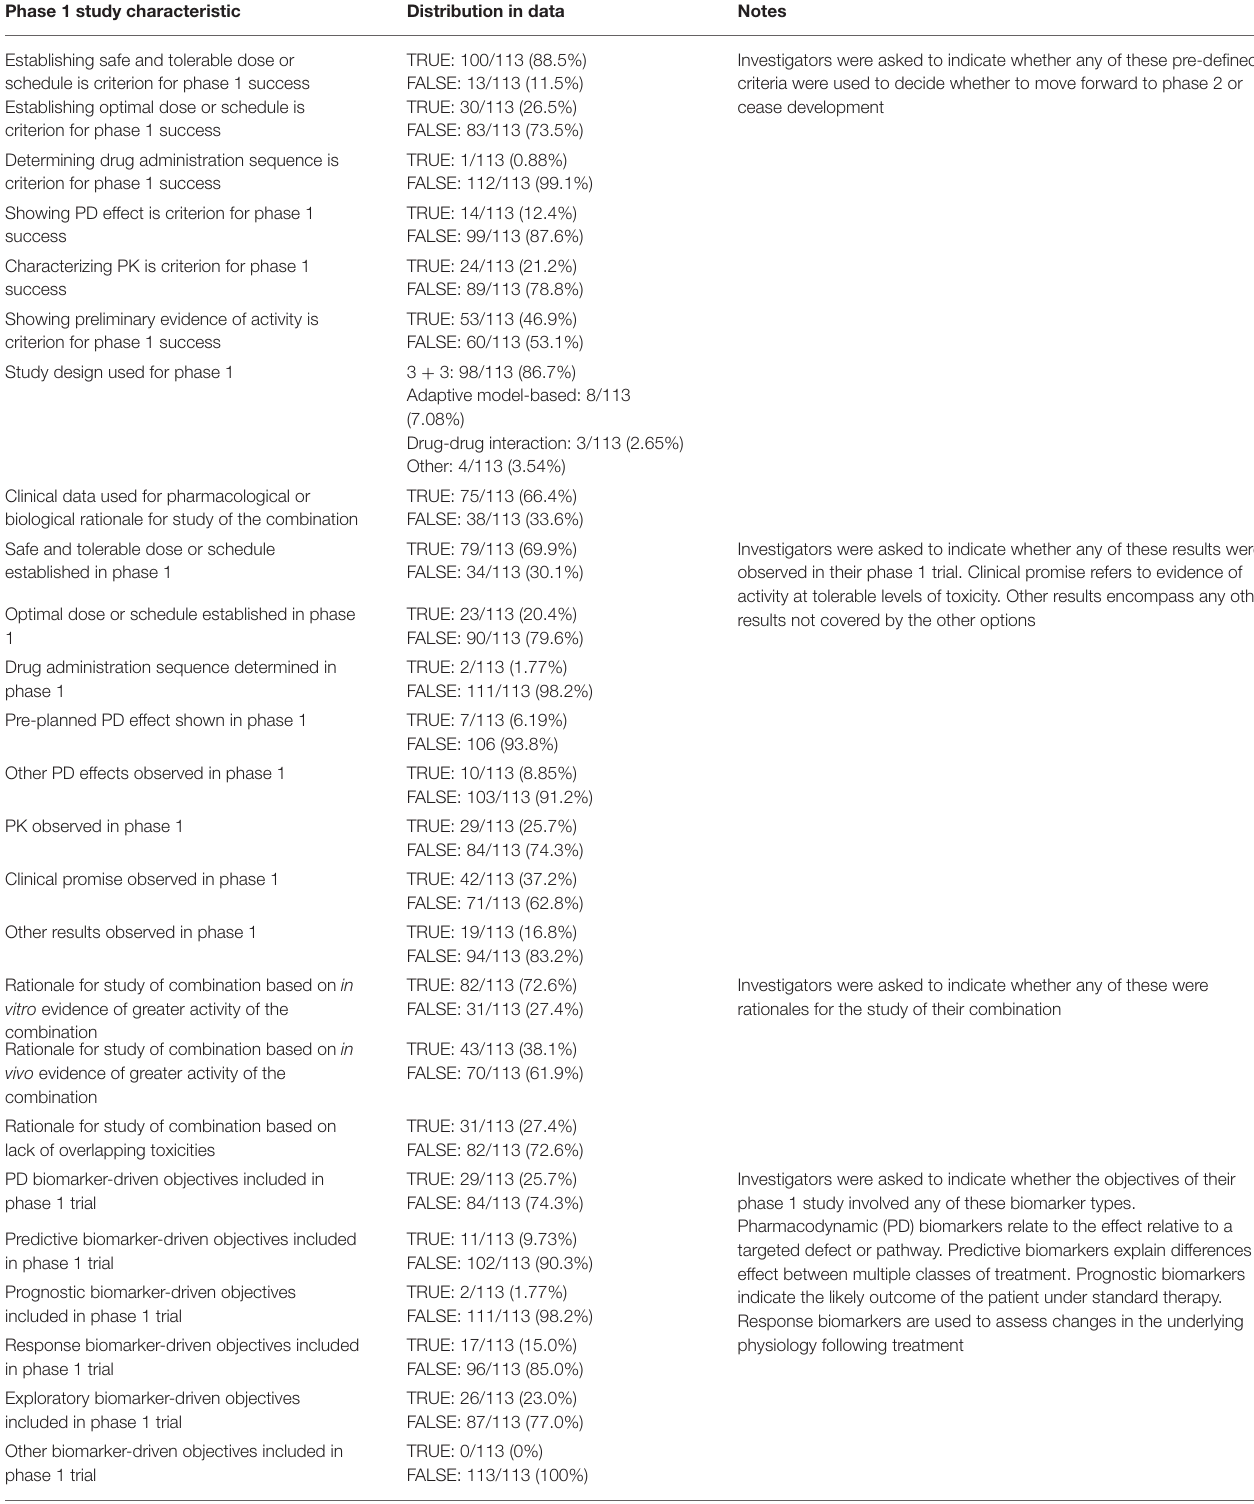
TABLE 4 | Summary statistics for the phase 1 study